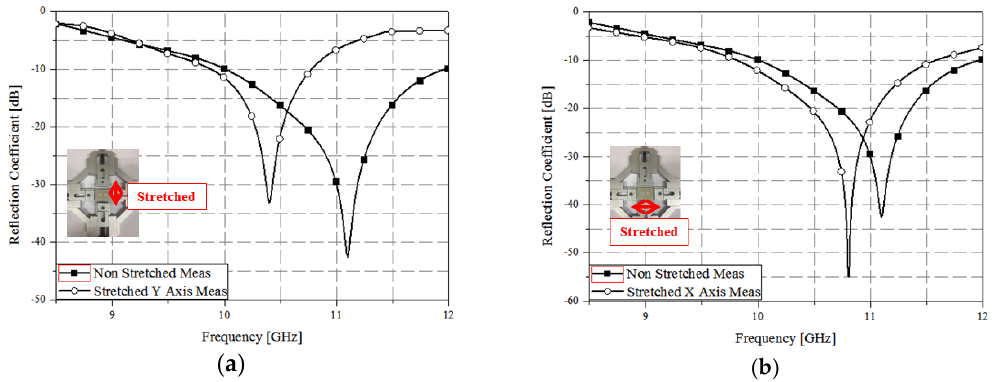
Figure 8. Measured reflection coefficient of the absorber stretched along ( a ) the x -axis and ( b ) the y -axis.